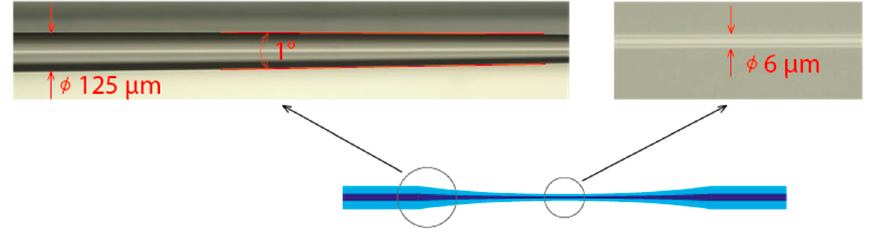
Figure 3. The optical image of the beginning of the taper transition and the taper waist before CNT coating deposition.